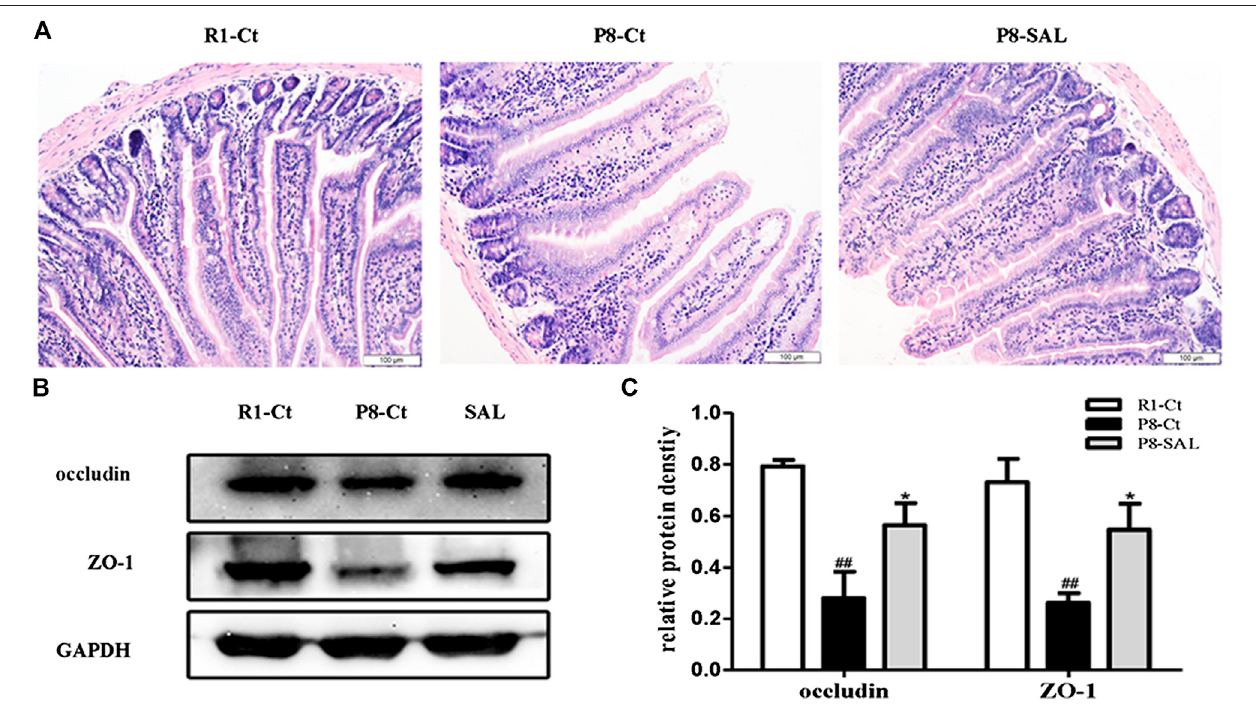
FIGURE5| EffectofSALontheintestinalbarrierinSAMP8mice. (A) HEstainingofmouseintestinaltissues(scalebar (cid:2) 100 μ m). (B) WesternblotanalysisofZO-1 and occludin in the intestine. (C) Protein quanti fi cation by western blotting. All data are shown as the mean ± SEM ( n (cid:2) 3 for each group). ## p < 0.01 versus the R1-Ct group and * p < 0.05 versus the P8-Ct